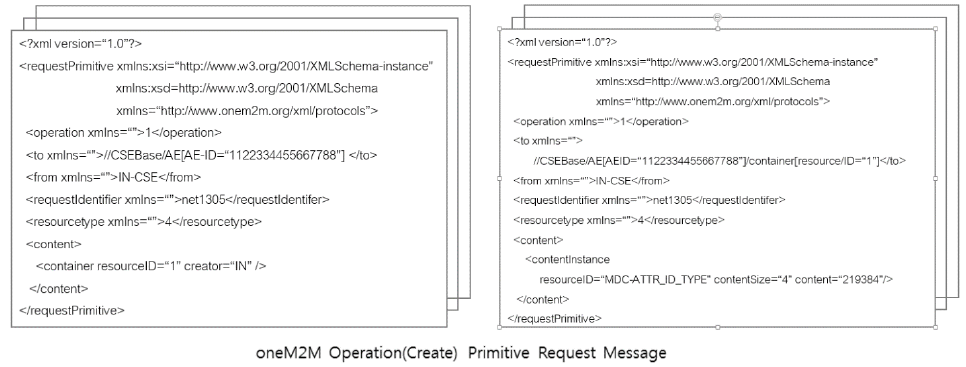
Figure 10. An example of the process described in Figure 8 (oneM2M Create primitive Request message).